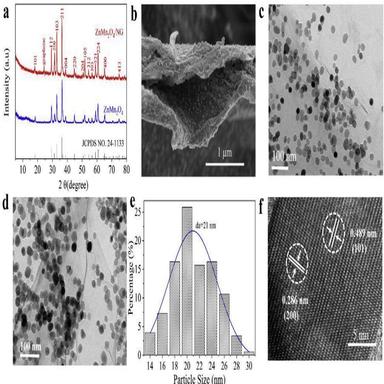
(a) XRD patterns of ZnMn2O4/NG and pure ZnMn2O4. (b) SEM, (c and d) TEM, (e) corresponded particle size distribution and (f) HRTEM images of prepared ZnMn2O4/NG.